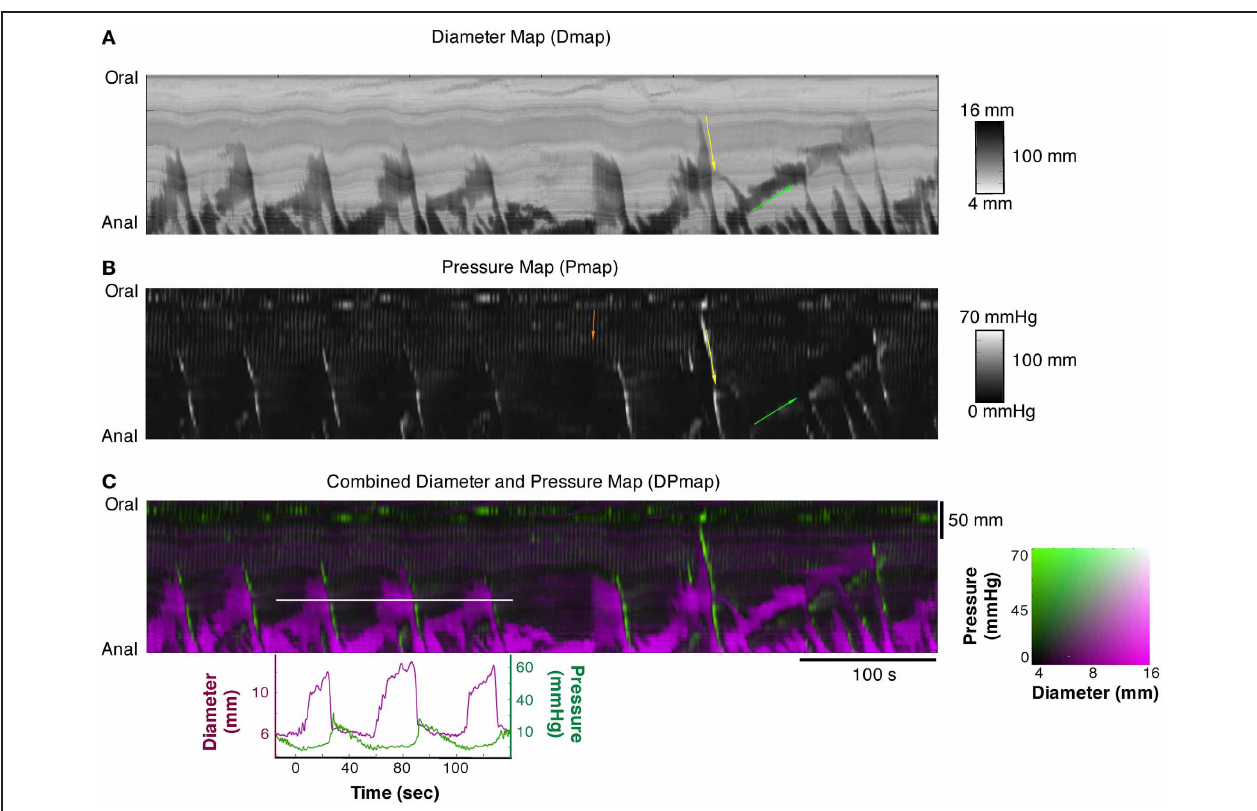
FIGURE 2 | (A) Diameter Map (Dmap); (B) Pressure Map (PMap); and (C) composite Diameter/Pressure Map (DPMap). In the Dmap (A) the dilated regions are shown as dark areas. Peristaltic propagating contraction can be seen at regular intervals (yellow arrow) originating predominantly around the mid-point of the specimen. Slowly propagating antiperistaltic contraction are also apparent (Green arrow). In the Pmap (B) the propagating contractions appear as white oblique lines (yellow arrow) and the anti-peristaltic propagating contractions are highlighted by the green arrow. In the proximal regions of the colon, a series of vertical gray lines can be seen in the PMap (Orange arrow). These cyclic changes in the pressure profile, that are not apparent in the Dmap, represent myogenic rhythmic activity generated by